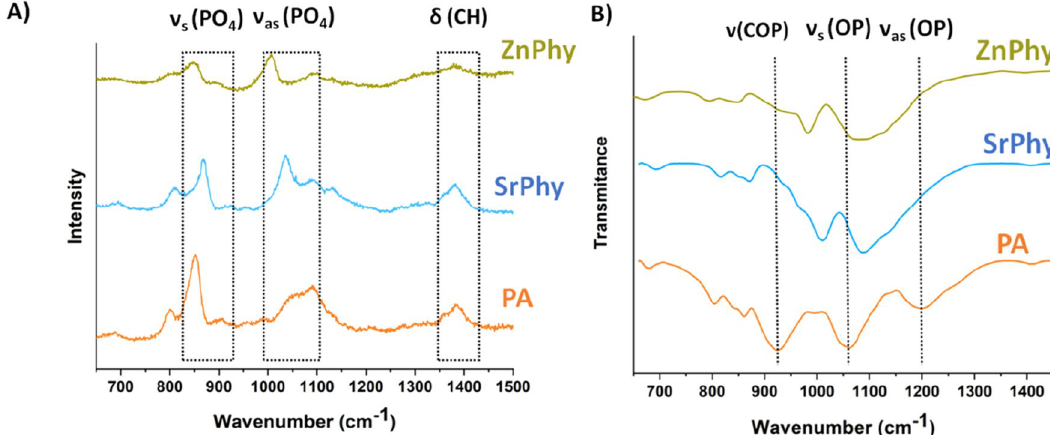
Figure 3. ( A ) Raman expanded spectra in the range from 650 to 1500 cm −1 and ( B ) ATR-FTIR